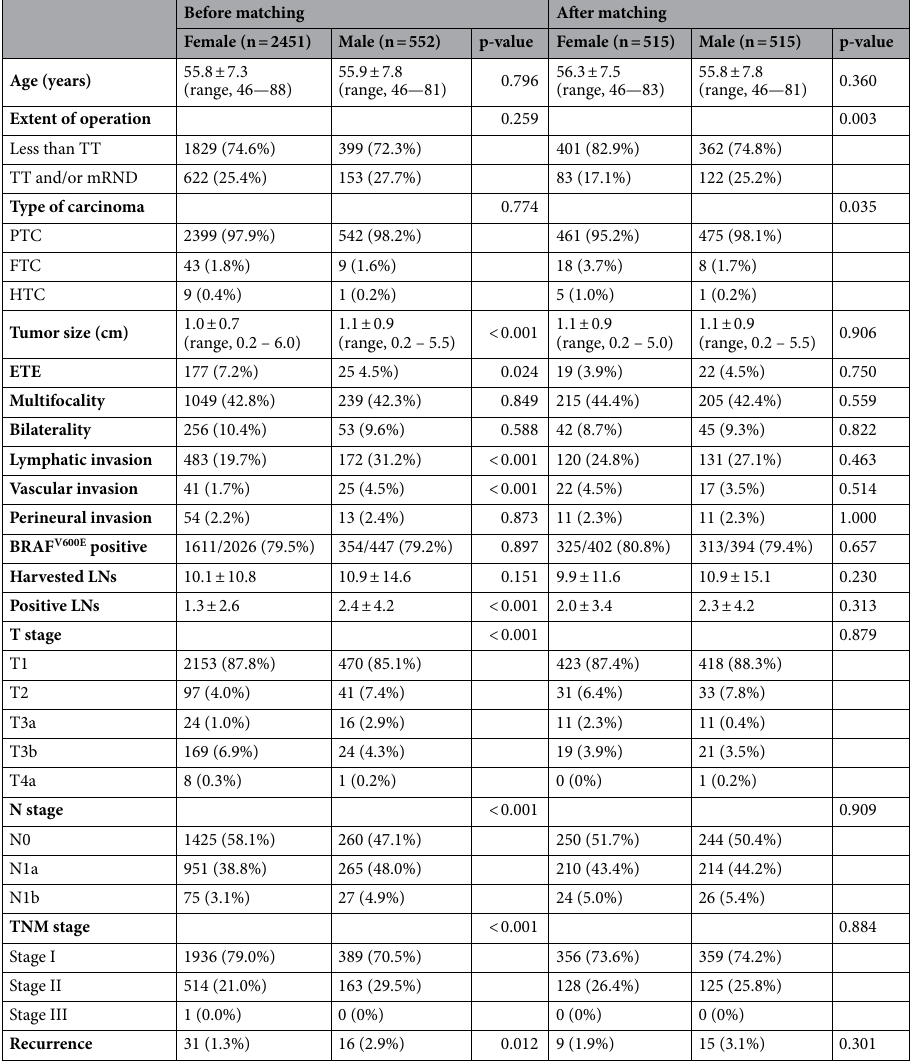
Table 6. Subgroup comparison between females and males aged > 45 years before and after propensity score matching. Data are expressed as patient’s number(%), or mean ± SD. A statistically significant difference was defined as p < 0.05. TT total thyroidectomy, mRND modified radical neck dissection, PTC papillary thyroid carcinoma, FTC follicular thyroid carcinoma, HTC Hürthle cell thyroid carcinoma, ETE extrathyroidal extension, LN lymph node, T tumor, N node, M